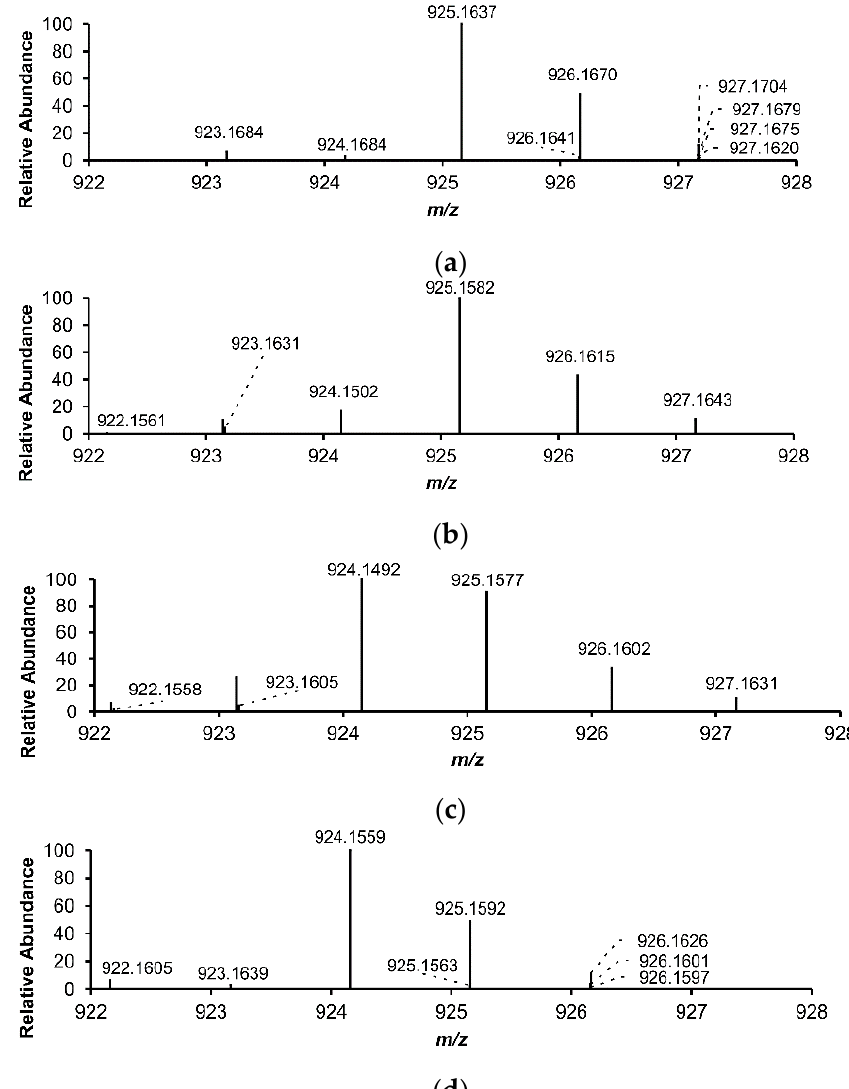
Figure 3. Details of recorded and simulated mass spectra of [3L+Fe II -H] + and [3L+Fe III -2H] + : ( a ) simulated spectrum of ( ± )-catechin with Fe II ; ( b ) recorded spectrum of ( ± )-catechin with Fe II mixture solution; ( c ) recorded spectrum of ( ± )-catechin with Fe III mixture solution; ( d ) simulated spectrum of ( ± )-catechin with Fe III , detected by nano-ESI–MS, positive ionization mode. The solu- tions were prepared by mixing the ( ± )-catechin solution with Fe II or Fe III in a molar metal-to-ligand ratio of